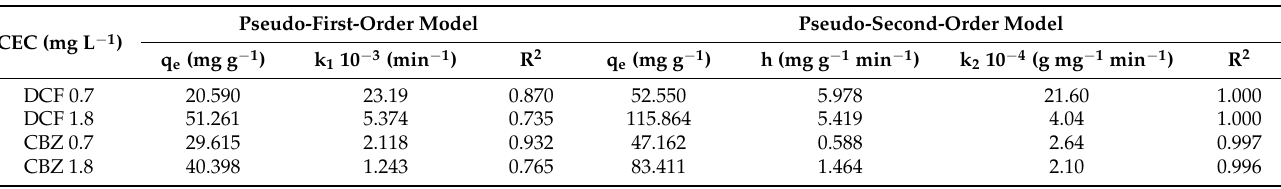
Table 3. Kinetic parameters for DCF and CBZ at different initial contaminant concentrations: pseudo-first-order, pseudo- second-order models.